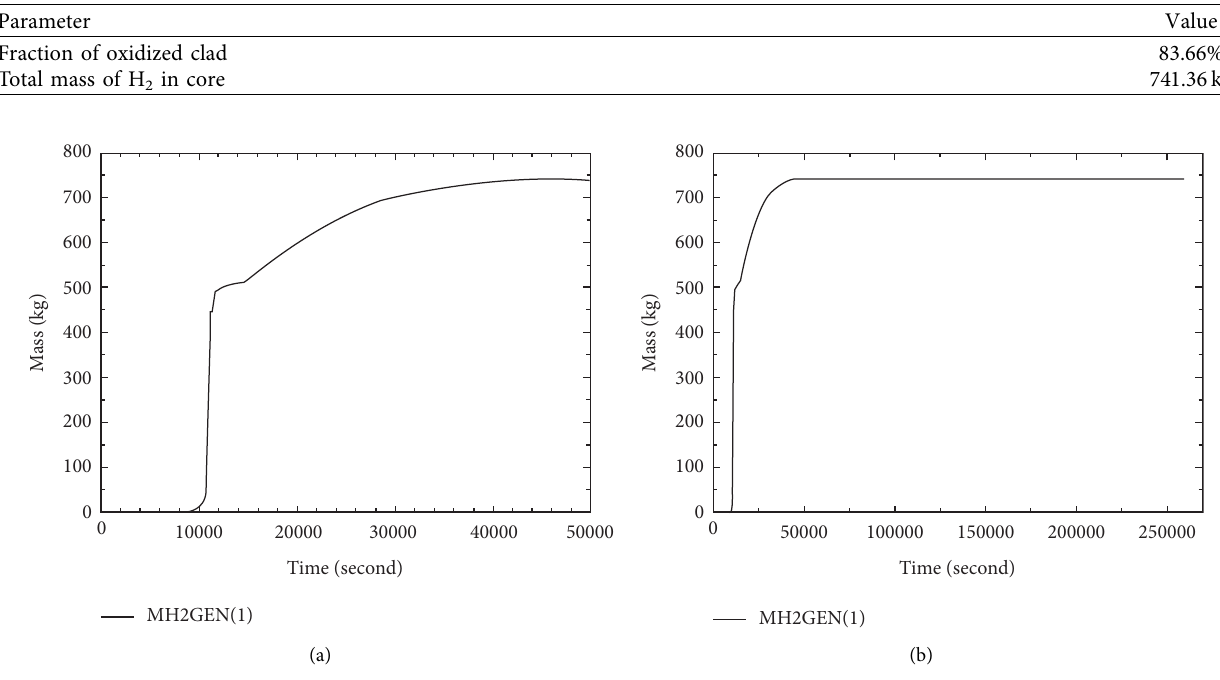
Figure 12: Total mass of hydrogen generated in core: (a) short term and (b) long term.